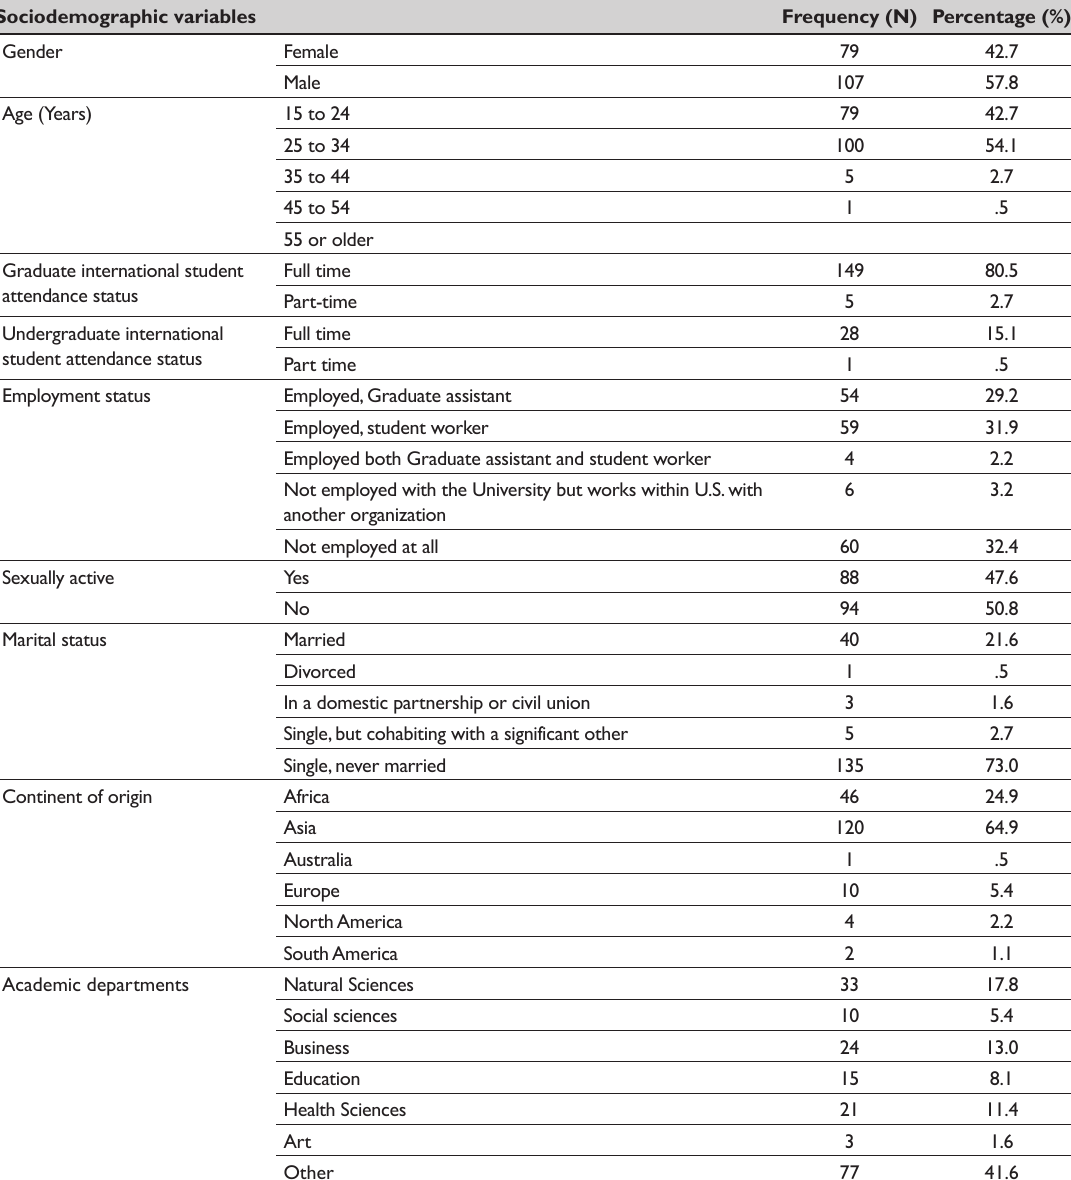
Table 1: Sociodemographic characteristics of study participants Sociodemographic